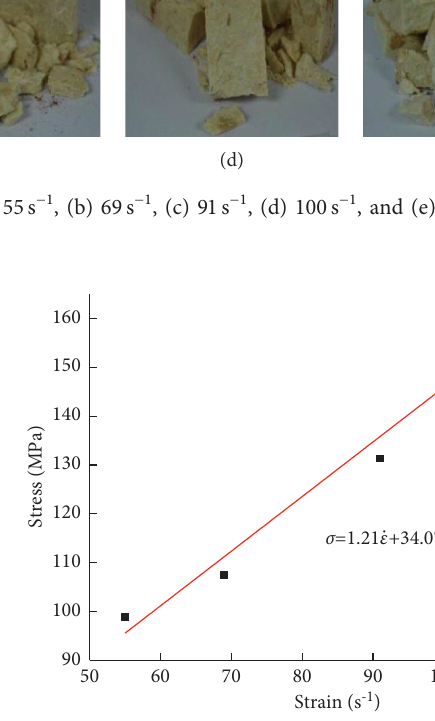
Figure 9: Curve of dynamic compressive strength with strain rate for